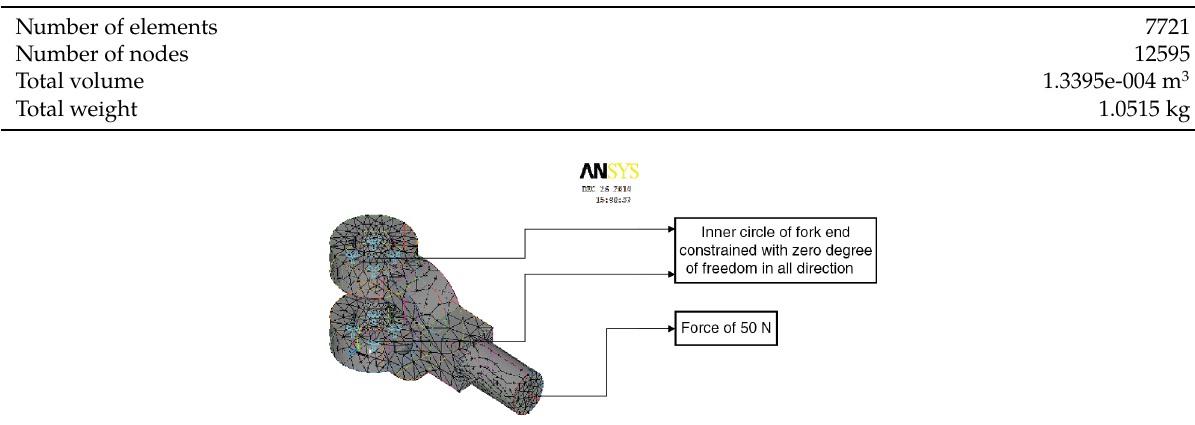
Figure 3: Loading and boundary conditions for the fork-end of a knuckle